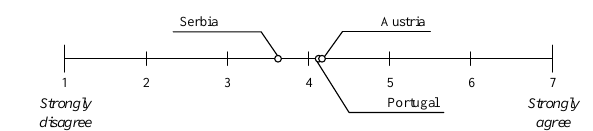
Figure 1: Respondents’ perception on the image